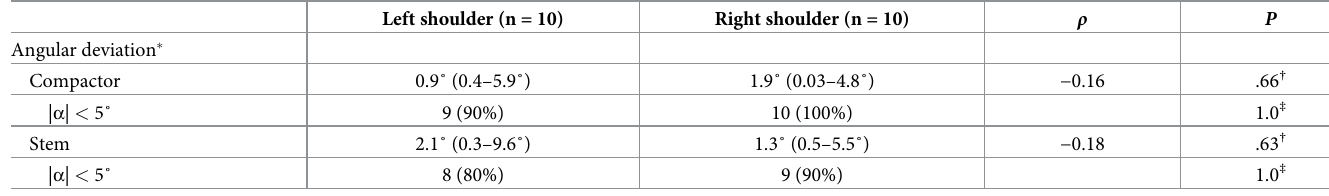
Fig 5. True anteroposterior humeral radiographs showing valgus positioned implants (size 7) ( A ) trial (alpha angle 6,8˚) ( B ) short-stem (alpha angle 8,2˚) in the same subject. https://doi.org/10.1371/journal.pone.0268075.g005 Table 3. Compactor and stem angular deviations compared between left and right